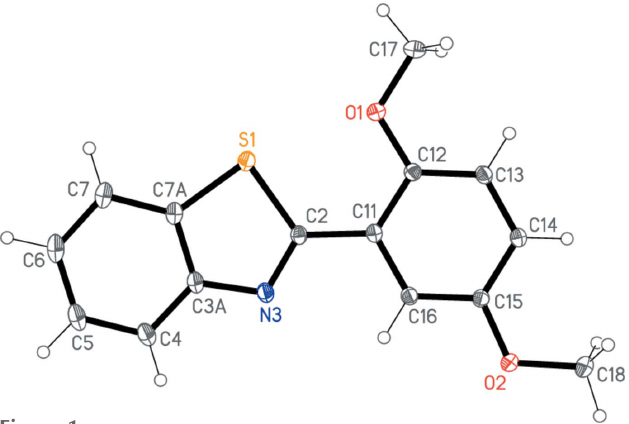
Figure 1 The molecule of 3 in the crystal. Ellipsoids represent 50% probability